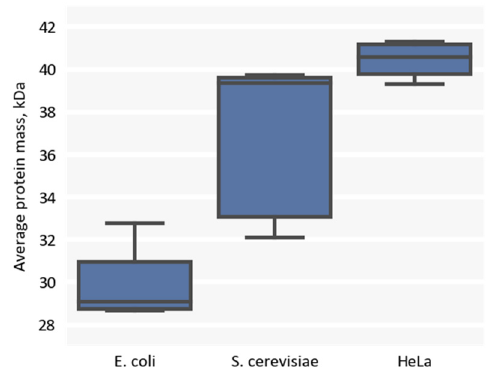
Figure 5. Distribution of average protein masses in the selected proteomic studies of E. coli , S. cerevisiae , and HeLa.